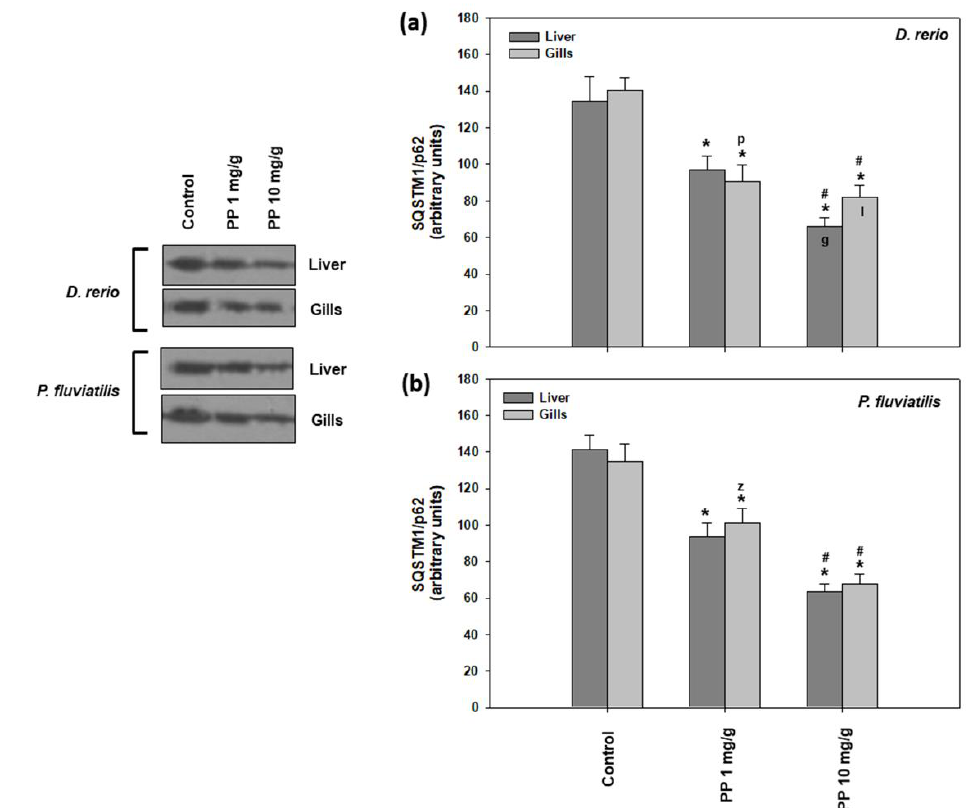
Figure 5. SQSTM1/p62 levels (mean ± SD) in the liver and gills of the Danio rerio ( a ) and Perca fluviatilis ( b ) control and dietary exposed to 1 mg PP-MPs/g and 10 mg PP-MPs/g dry food. Asterisk (*) denotes significant differences ( p < 0.05) compared to the control group, dash (#) denotes significant differences ( p < 0.05) between the two examined concentrations: 1 mg PP-MPs /g and 10 mg PP-MPs/g, lower case letters “z” and “ p ” denote significant differences ( p < 0.05) between the two examined species D. rerio and P. fluviatilis , respectively, while lower case letters “g” and “l” denote within species significant differences ( p < 0.05) between the gills and liver, respectively.